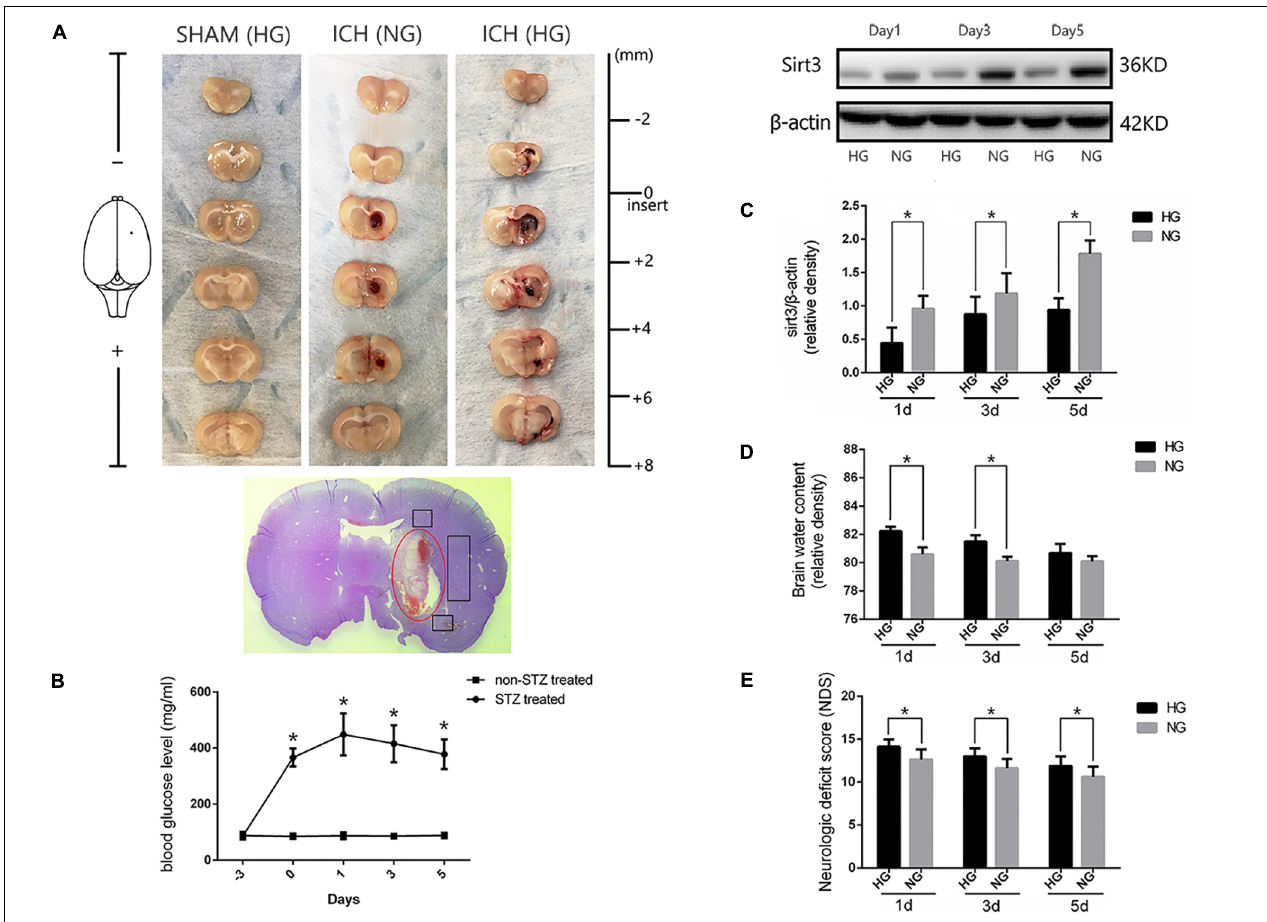
FIGURE 1 | Hyperglycemia suppressed sirt3 expression and aggravated cerebral injury after ICH. (A) Representative images of brain sections in each group. HE staining of ICH and the bleeding site (red circle). (B) Glucose levels of streptozotocin (STZ) treated and non-STZ-treated rats before and after experimental intracerebral hemorrhage (ICH), ∗ P < 0.05 versus non-STZ-treated group ( n = 6 in each group). (C) Western blotting showed the sirt3 protein expression in HG and NG group on days 1, 3, and 5 after ICH, ∗ P < 0.05 ( n = 6 in each group). HG, high blood glucose; NG, normal blood glucose. (D) The comparison of brain water content in HG and NG group on days 1, 3, and 5 after ICH, ∗ P < 0.05 ( n = 6 in each group). (E) The comparison of neurologic deficit scores in HG and NG group on days 1, 3, and 5 after ICH, ∗ P < 0.05 ( n = 9 in each